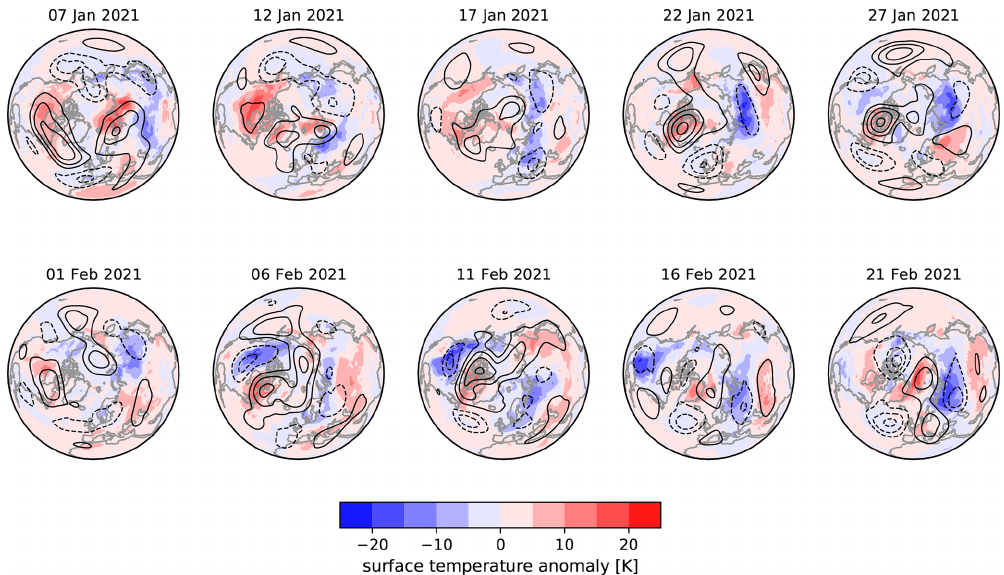
Figure 11. Consecutive 5d mean maps of ERA5 2m temperature (shading) and 500hPa level geopotential height (500GPH, contours) anomalies for the period following the SSW. Values are shown as anomalies from a 1979–2020 climatology for the given dates. The 500GPH contours are at 100m intervals, negative values are dashed and the zero contour is